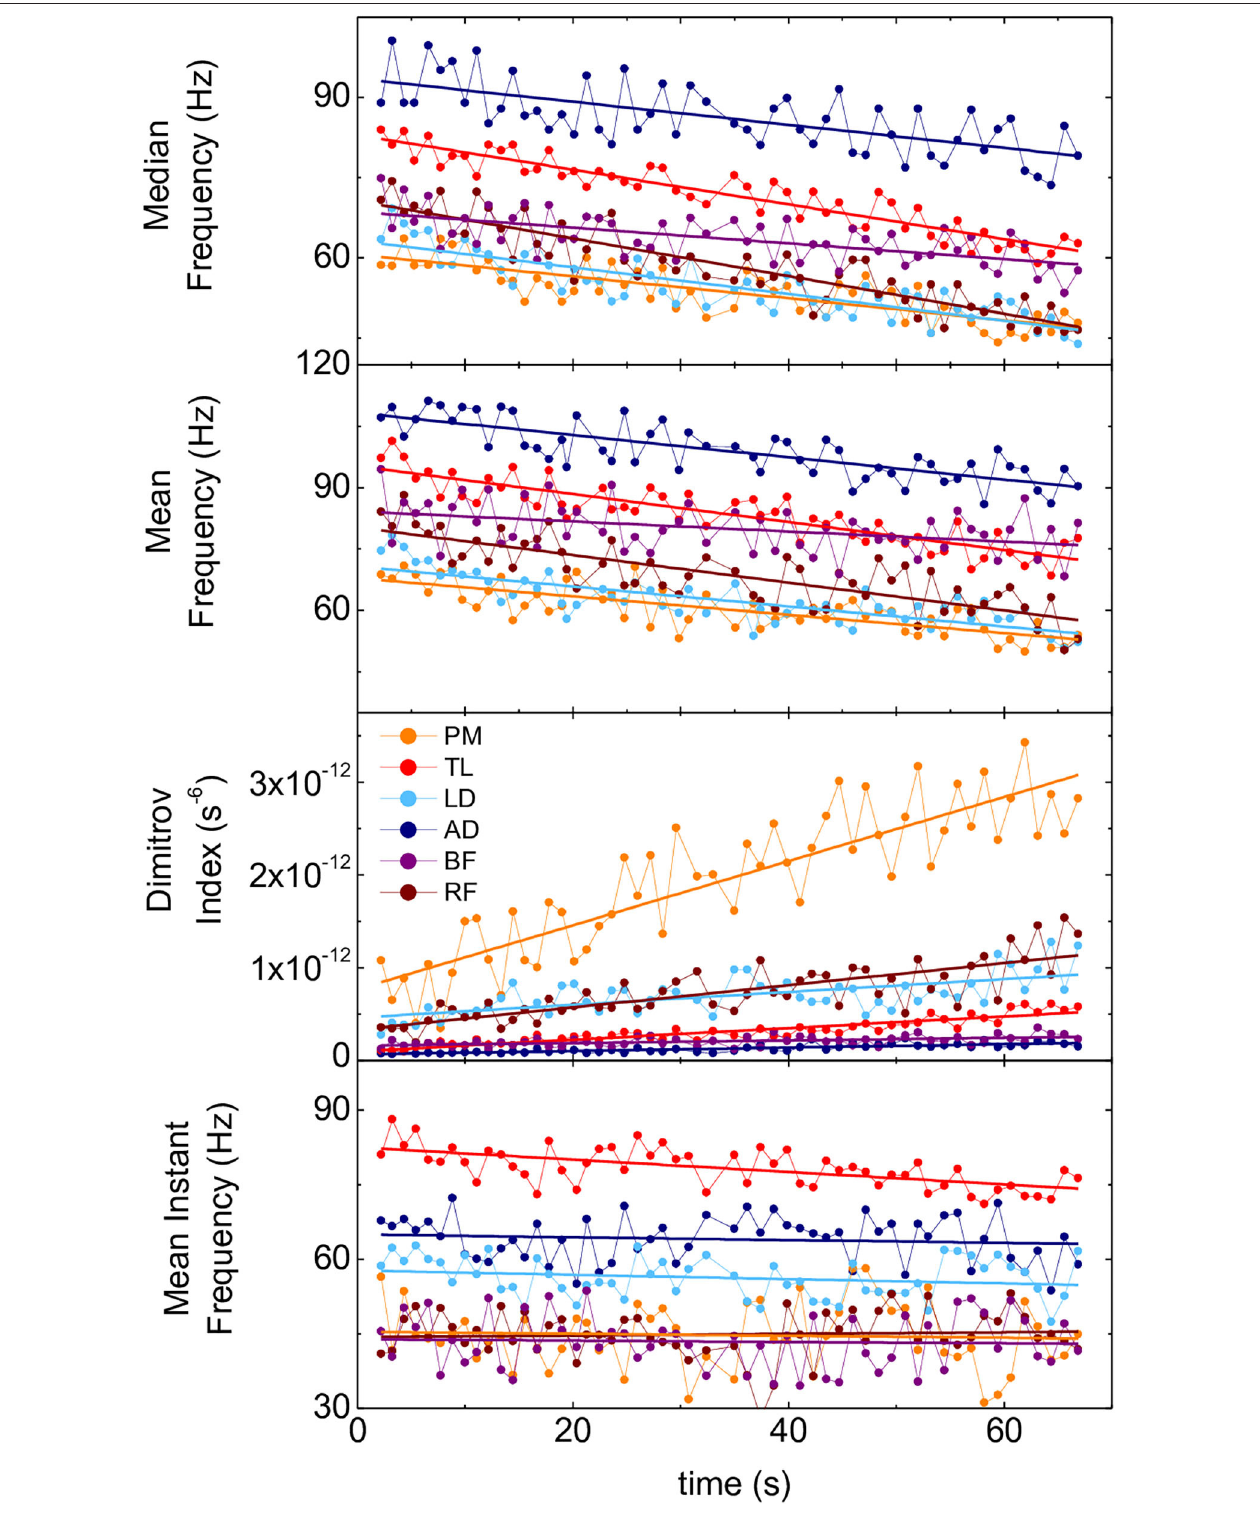
FIGURE 3 | Time evolution of spectral parameters of the 6 muscles of one representative participant during the SFT. Panels from top to bottom: F med , F mean , DI, F mi . PM, pectoralis major; TL, triceps lateralis; LD, latissimus dorsi; AD, anterior deltoid; BF, biceps femoris; RF, rectus femoris.